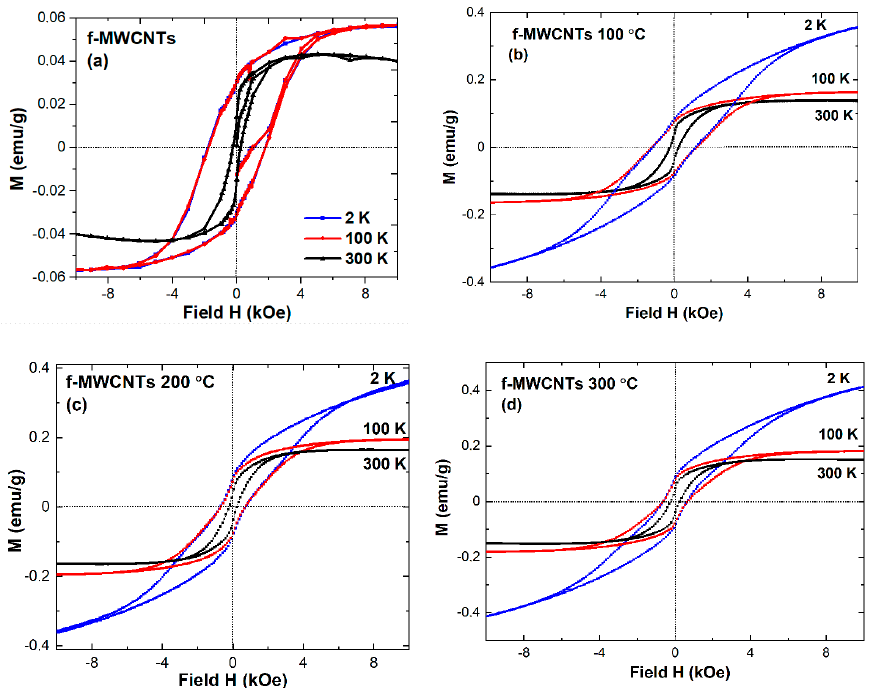
Figure 12. Hysteresis loops M ( H ) measured at 2 K, 100 K, and 300 K for f-MWCNTs: ( a ) pristine; ( b ) calcined at 100 °C; ( c ) calcined at 200 °C; ( d ) calcined at 300 °C. Table 2. Magnetic properties of pristine and calcined f-MWCNTs.